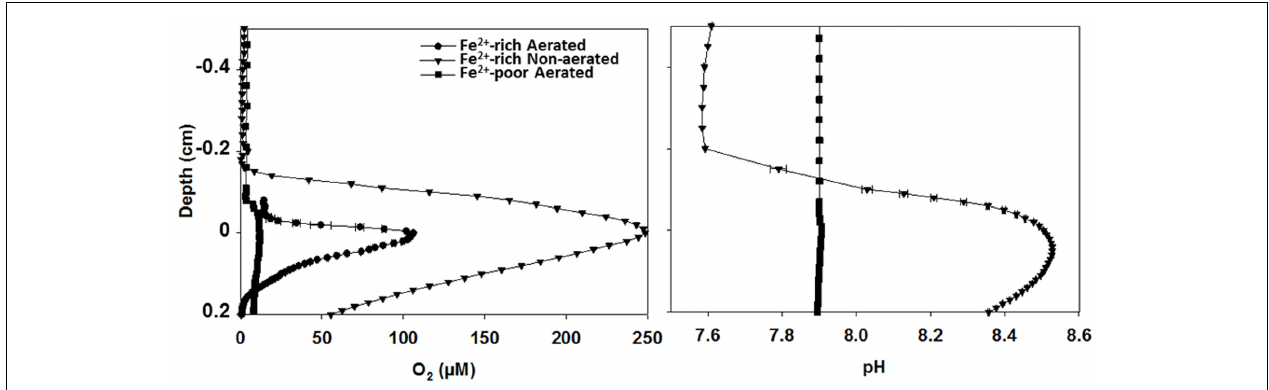
FIGURE 2 | In-situ O 2 and pH microprofiles in cyanobacterial biofilms from aerated and non-aerated Fe 2 + -rich and aerated Fe 2 + -poor reactors. All profiles were measured under similar irradiance as that used during